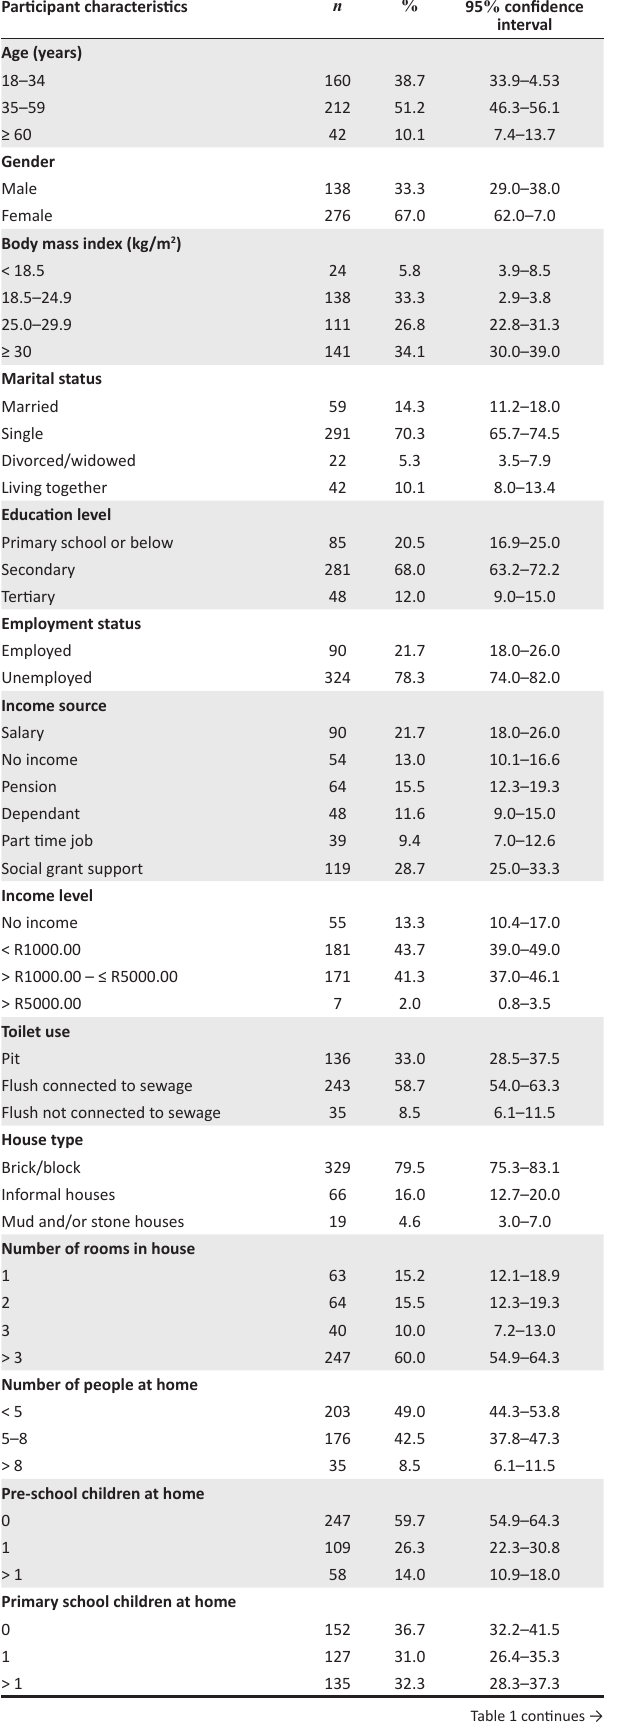
TABLE 1: Demographic profiles of study participants. Participant characteristics